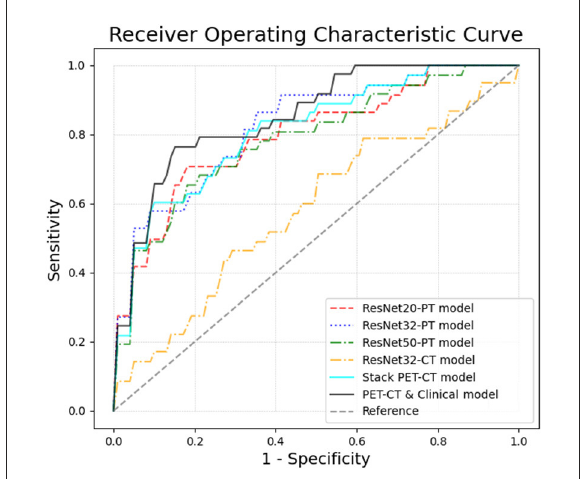
FIGURE2 The ROC curves of different models in 5-fold cross validation. By integrating the clinical information and images, the Stack PET/CT and Clinical model obtained the highest AUC at 0.85 ± 0.09. The stacked PET/CT model and ResNet PET models also obtained relatively high AUCs of 0.79 ∼ 0.82 ± 0.07 ∼ 0.08. The ResNet CT models and radiomic model showed low predictive